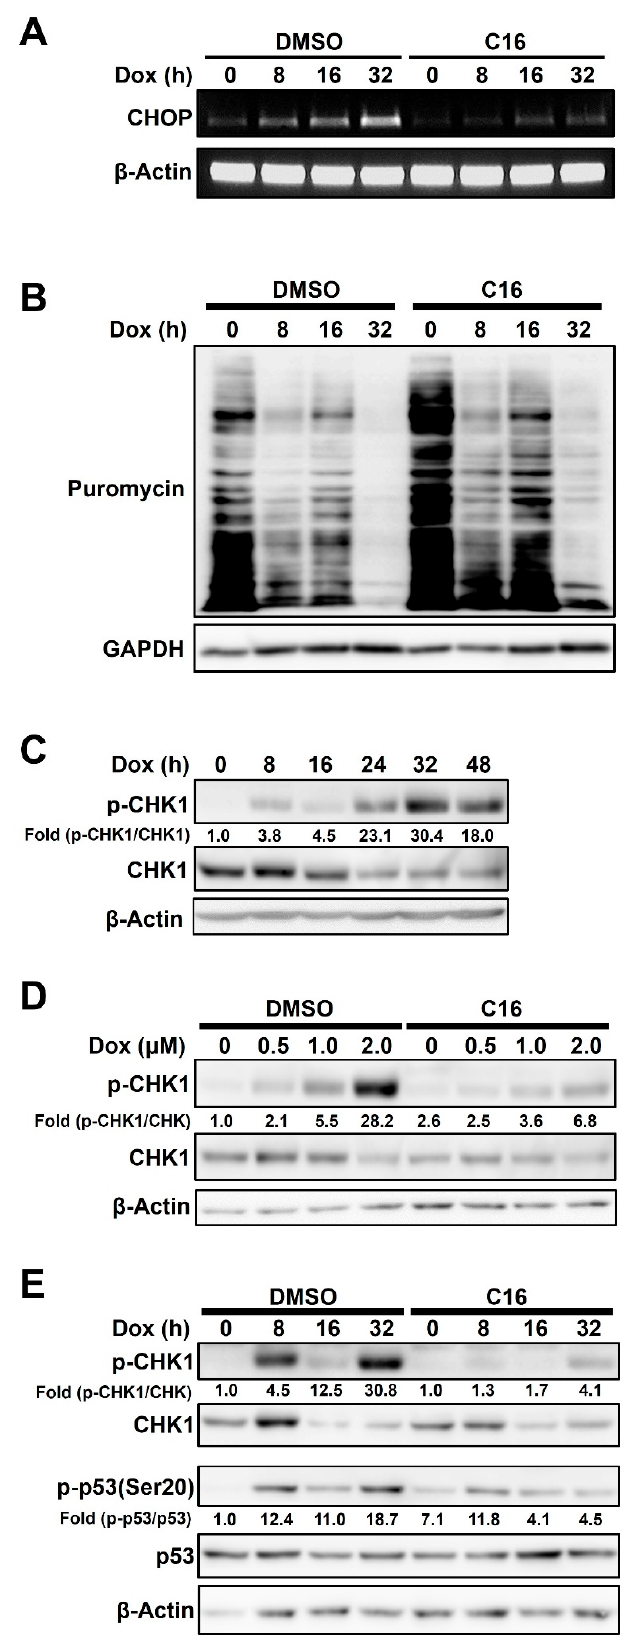
Figure 4. Doxorubicin-induced PKR-mediated apoptosis is caused by eIF2 α /CHOP signaling and checkpoint kinase 1 (CHK1) phosphorylation in HCC1143 cells. ( A , B ) Cells pretreated with or